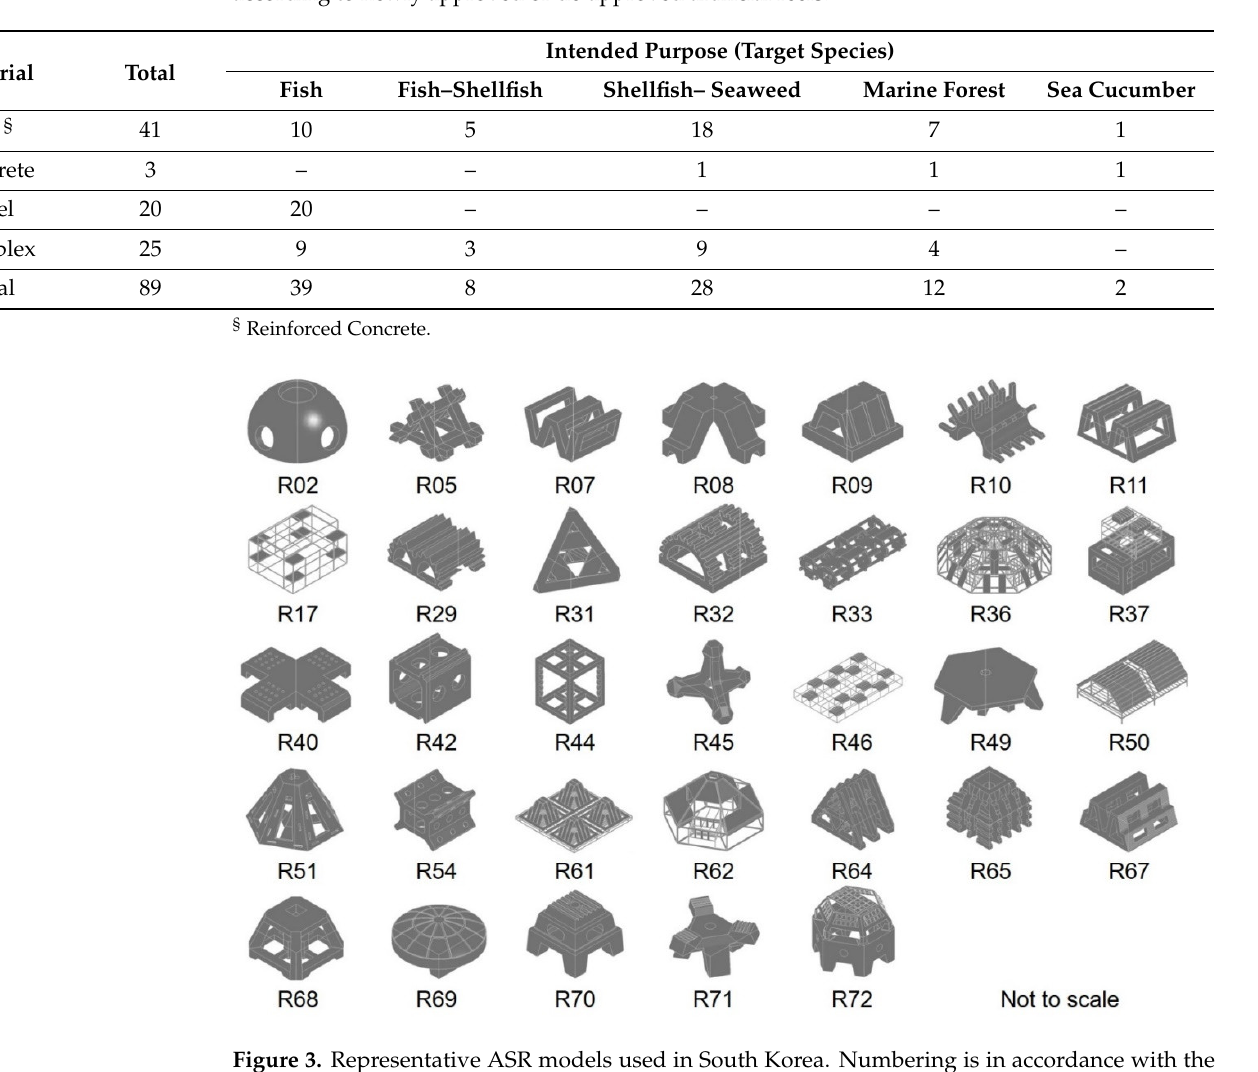
Figure 3. Representative ASR models used in South Korea. Numbering is in accordance with the artificial reef information book published by the FIRA [356].